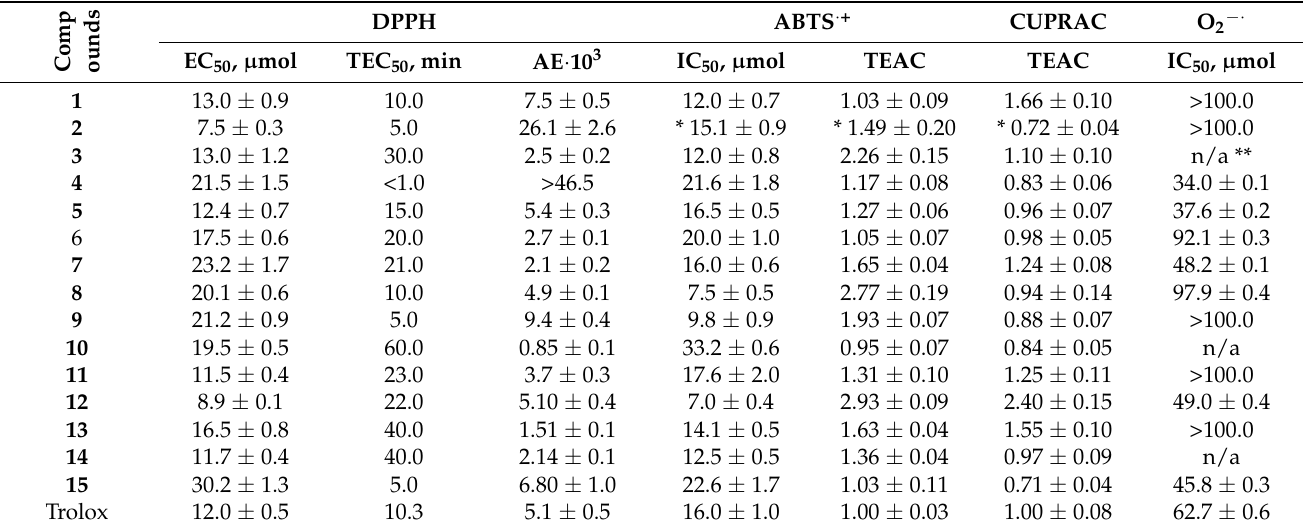
Table 1. The values of EC 50 , TEC 50 , AE (antiradical efficiency) in DPPH test (MeCN, 298 K), index of IC 50 and TEAC in ABTS · + assay, Cu 2+ reduced activity in Trolox equivalents (CUPRAC) and superoxide radical anion scavenging activity of target compounds in IC 50